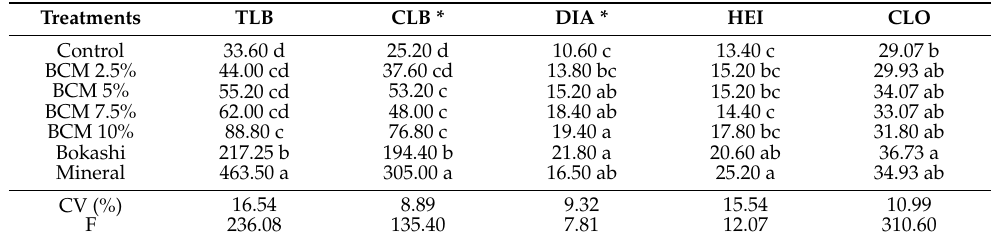
Table 2. Mean of production variables of radicchio chicory submitted to boiled chicken manure (BCM), Bokashi, or mineral fertilizer. Londrina, Brazil, 2020.